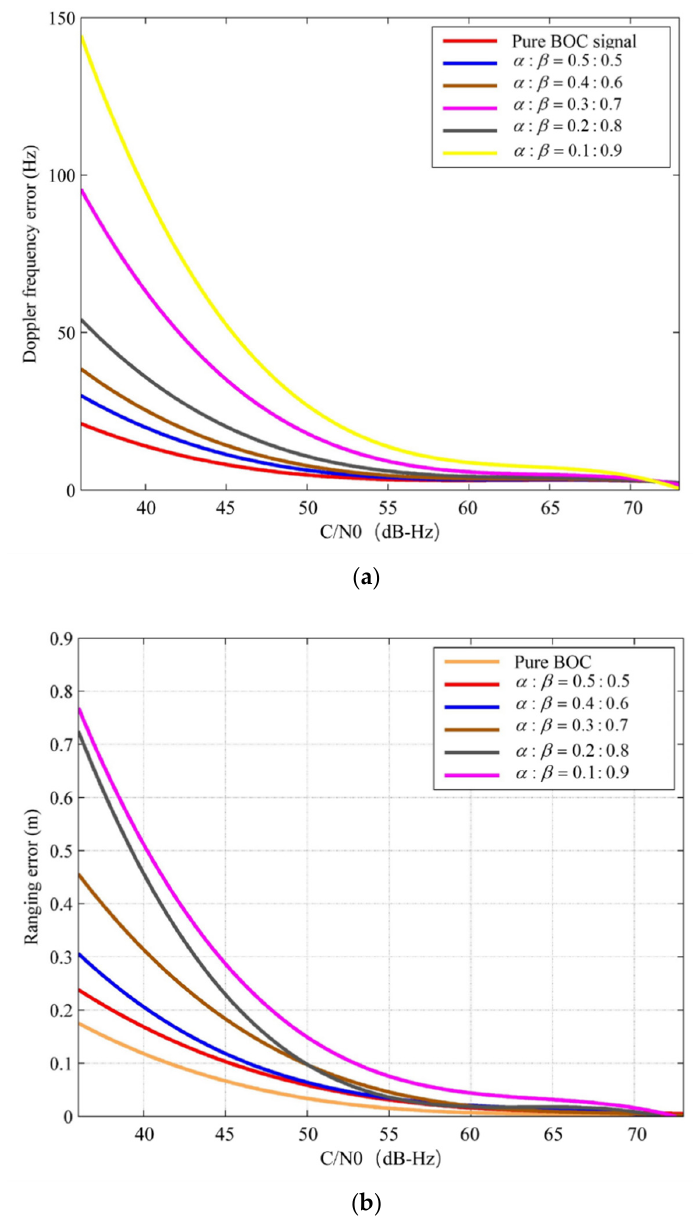
Figure 10. Performance of the composite signal and pure signal: ( a ) Doppler frequency measurement results of the composite signal and pure BOC signal, and ( b ) ranging results of the composite signal and pure BOC signal.